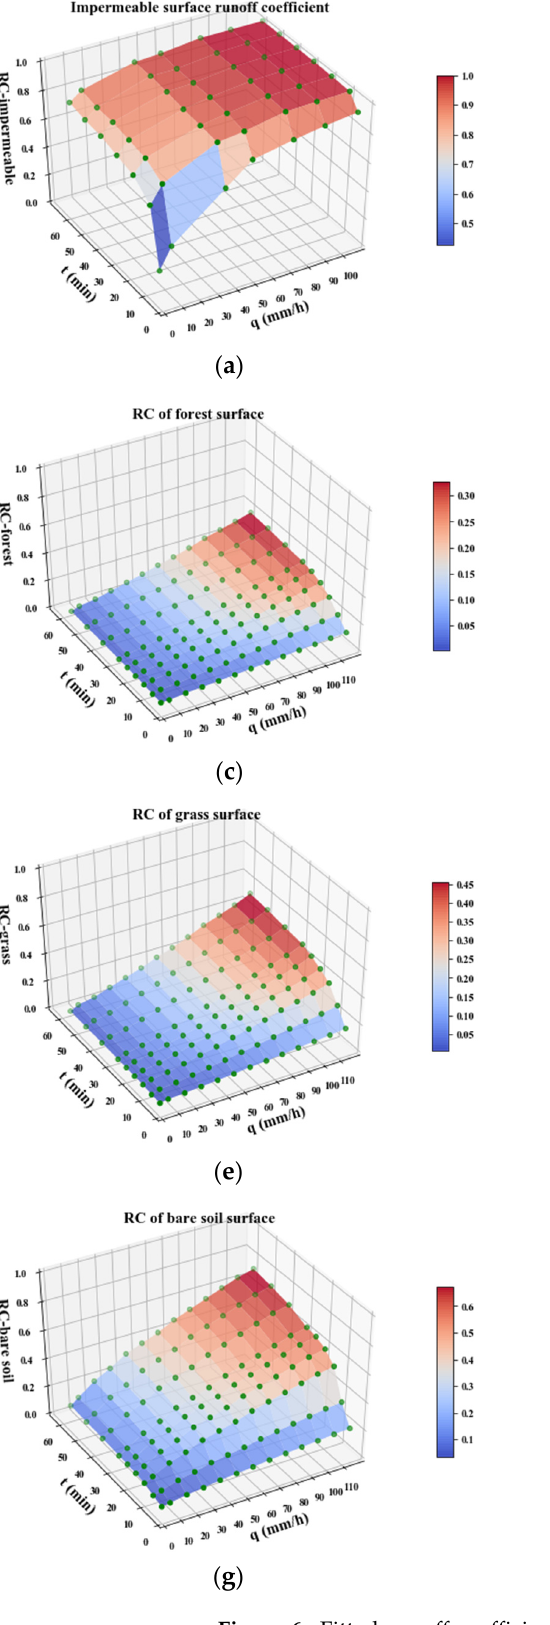
Figure 6. Fitted runoff coefficients of four land cover types with higher occupancy for the three rainfall input models ( ▲ a = 10, ● a = 50, ■ a = 100). ( a , b ): impermeable surface; ( c , d ): forest surface; ( e , f ): grass surface; ( g , h ): bare soil surface. Experimental values (left). Interpolated fitted data (right).